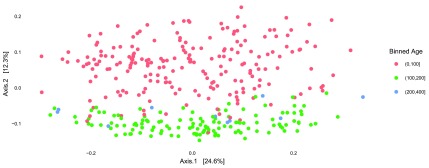
A PCoA plot using Bray-Curtis distance between samples.